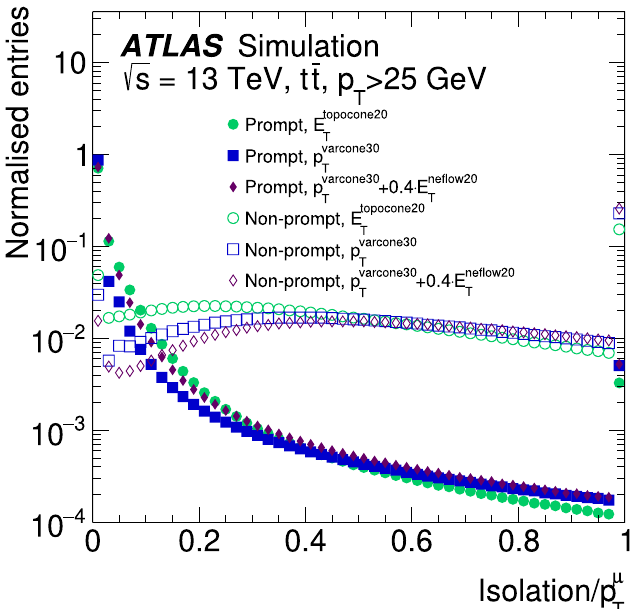
Fig. 5 Distributions of the isolation variables defined in Sect. 5.3, after dividing their value by the p T of the muon. Prompt and non-prompt muons are extracted from simulated t ¯ t events. The distributions are normalised to unit area. The rightmost bin contains all the events exceeding the range of the horizontal